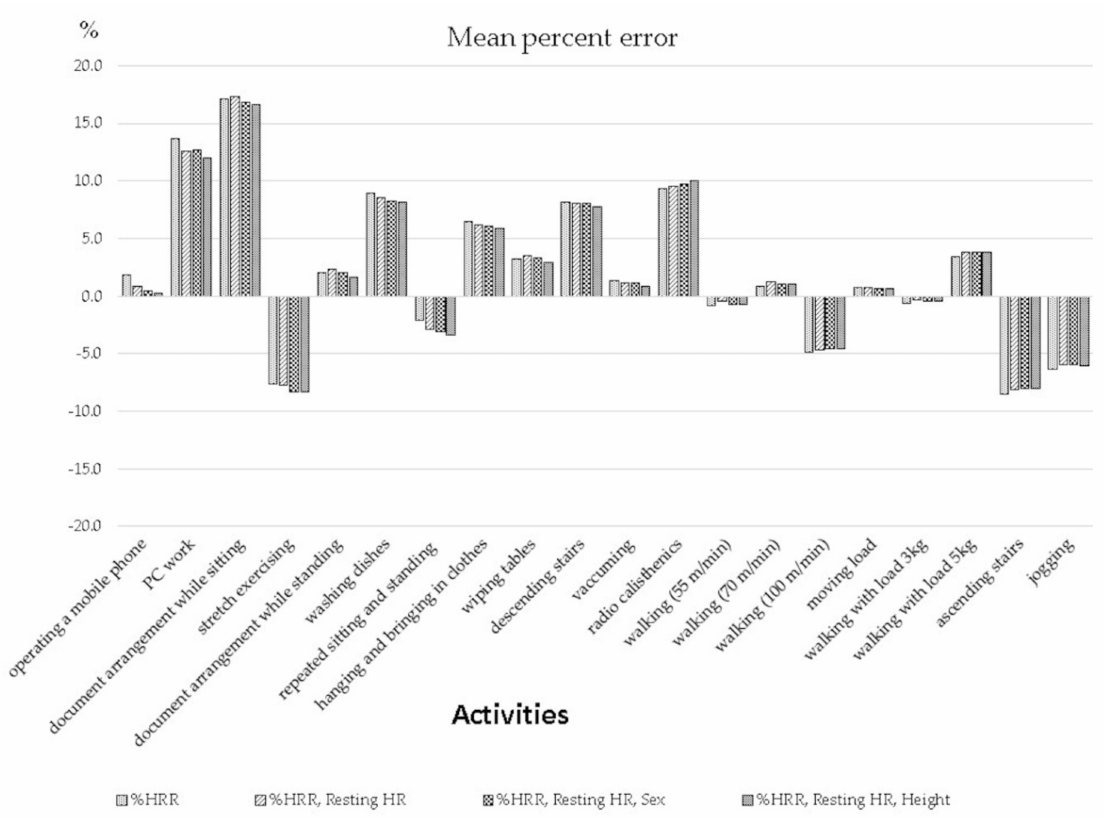
Figure 2. Mean percent error of each equation validated by leave-one-out (n =